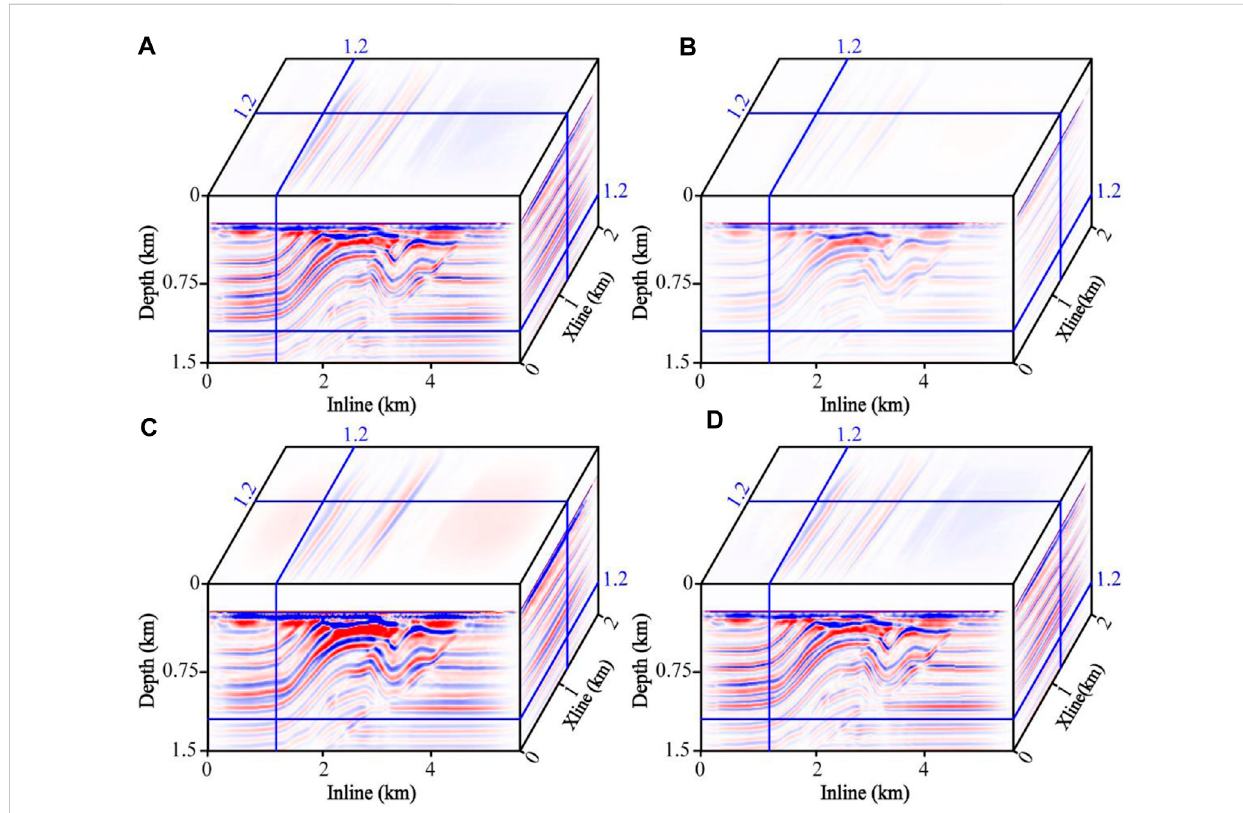
FIGURE 12 Migrated images of 3D overthrust model. (A) acoustic RTM to acoustic data; (B) acoustic RTM to viscoacoustic data; (C) average Q -compensated RTM; (D) constant-order compensated RTM.